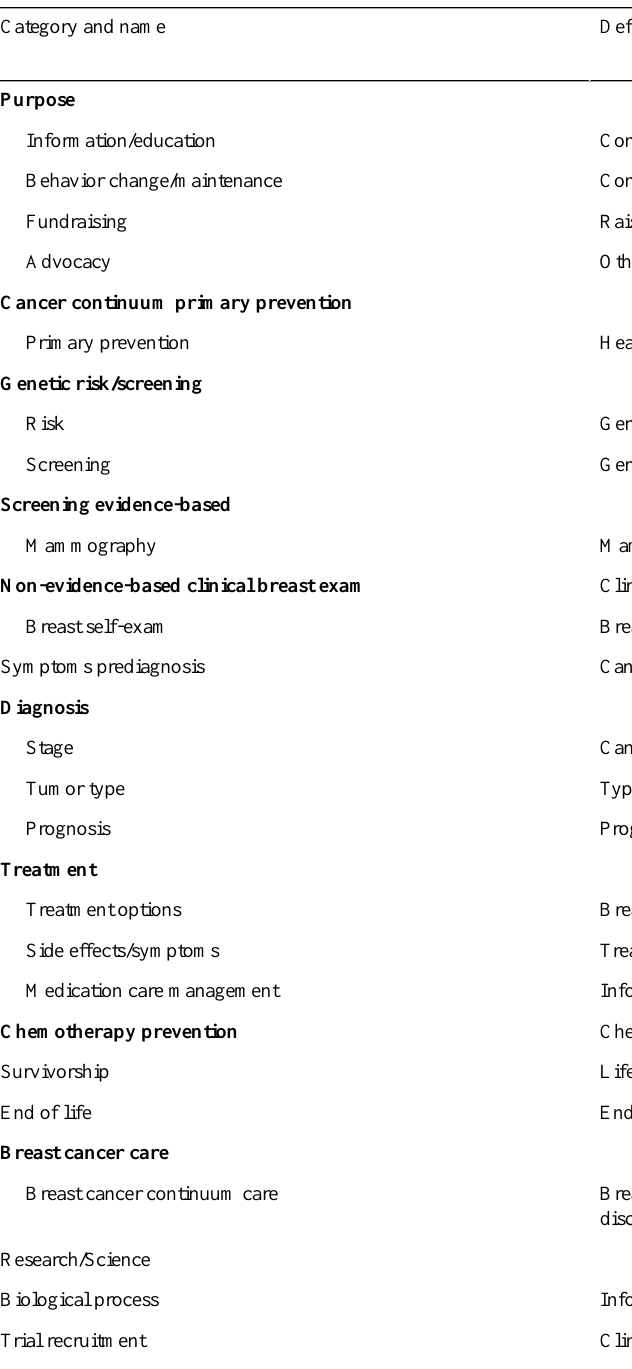
Table 1. Variable categories, names, definitions, and intercoder